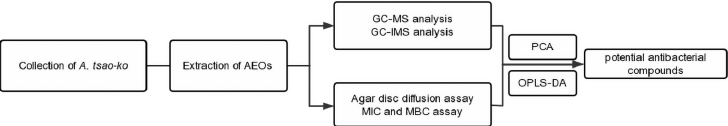
Figure 2. Schematic diagram of the experimental